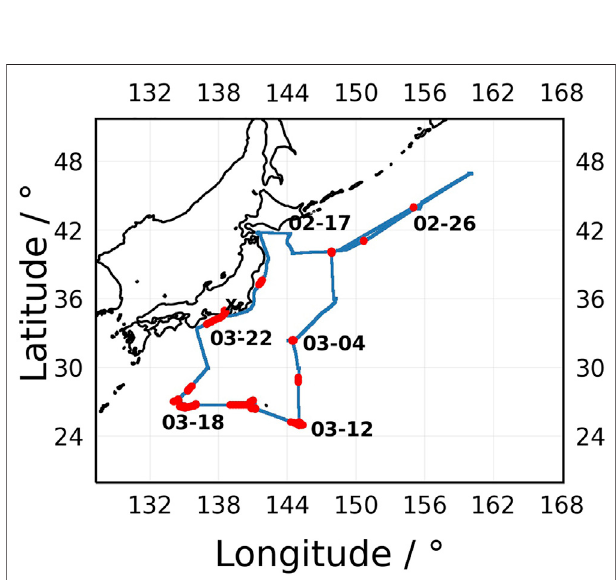
FIGURE 1 | Trajectory of RV Mirai through the Western Paci fi c in the vicinityofJapanleavingShimizuporttowardstheEast.Reddotsindicatevalid measurement positions of the mobile EM27/SUN. For selected samples, the measurement dates are indicated.